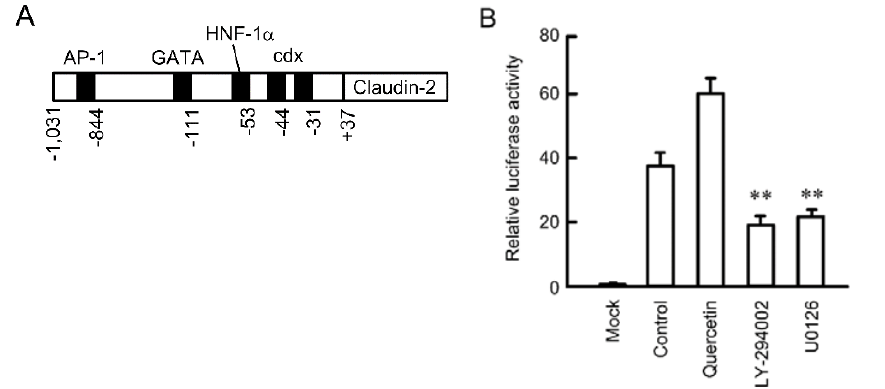
Figure 4. Effect of quercetin on the reporter activity of claudin-2. ( A ) Schematic drawing of transcriptional binding sites in human claudin-2 promoter; ( B ) A549 cells were co-transfected with luciferase pGL4.10 vector and pRL-TK vector. After 24 h of transfection, the cells were incubated in the absence and presence of 50 μM quercetin, 10 μM LY-294002, or 10 μM U0126 for 24 h. The relative promoter activity of claudin-2 was represented as the fold induction compared to that of the promoter-less pGL4.10 vector (mock). n = 4. ** p < 0.01 significantly different from